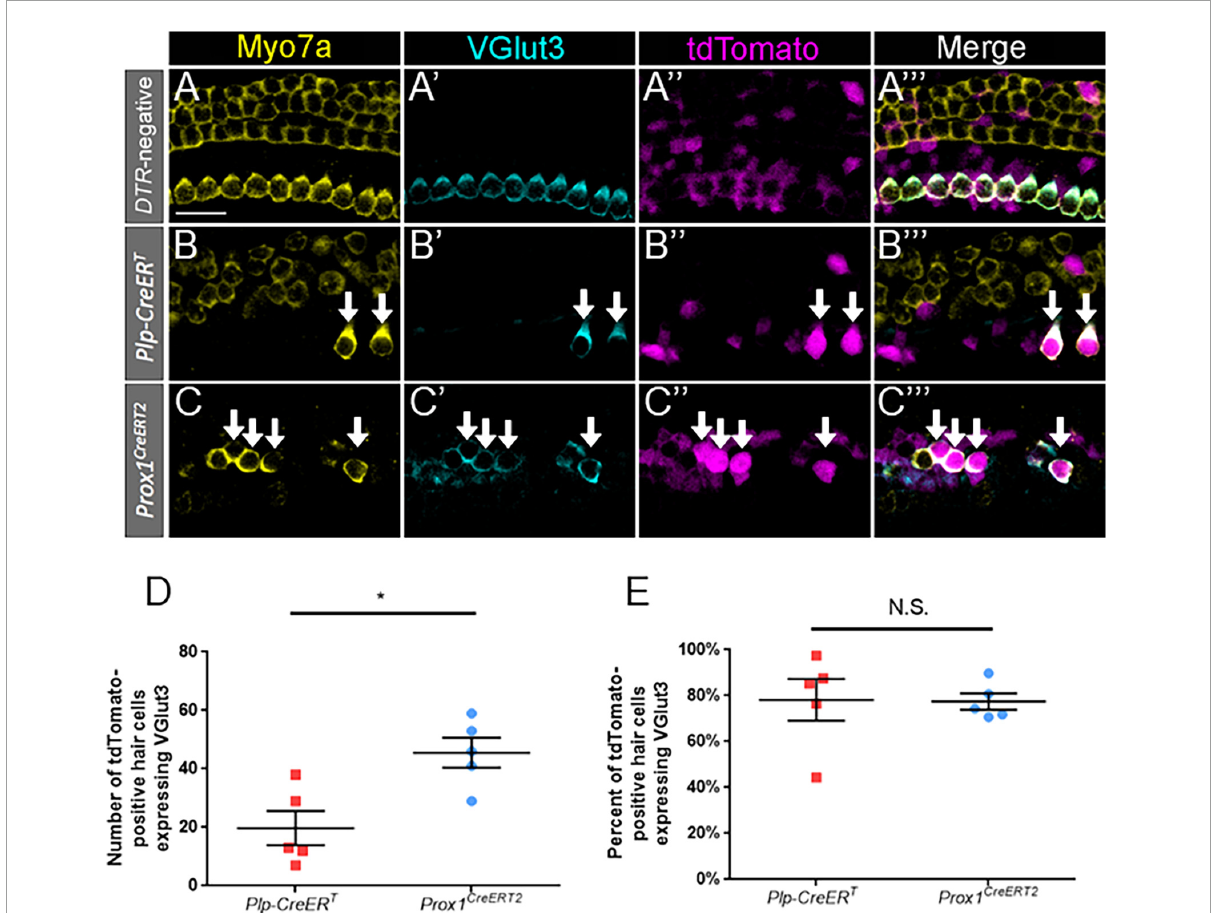
FIGURE5 VGlut3 is expressed in a similar proportion of regenerated hair cells across supporting cell subtypes. (A–C”’) Representative confocal slice images from the apical turn of Pou4f3 DTR -negative (A–A”’) , middle turn of Plp-CreER T :Rosa26 tdTomato :Pou4f3 DTR (B–B”’) , and apical turn of Prox1 CreERT 2 :Rosa26 tdTomato :Pou4f3 DTR (C–C”’) mice at P7–P8 that were injected with tamoxifen at P0 to induce tdTomato expression in the two supporting cell subpopulations and with DT at P1 to induce hair cell damage. Samples were immunostained with anti-Myo7a antibodies (yellow) to label hair cells and anti-VGlut3 antibodies (blue) to label mature inner hair cells. tdTomato was detected using endogenous fluorescence (magenta). Arrows indicate Myo7a-positive/VGlut3-positive/tdTomato-positive cells that are regenerated, fate-mapped mature inner hair cells. Scale bars: 25 µ m. (D) Significantly more regenerated hair cells derived from supporting cells in the lateral compartment and fate-mapped by Prox1 CreERT 2 expressed VGlut3. (E) When normalized to the total number of tdTomato-positive/Myo7a-positive cells, there was no significant difference in the percentage of VGlut3-positive regenerated hair cells between the supporting cell populations targeted by the two CreER lines. * p < 0.05, determined using an unpaired Student’s t -test. Data are presented as mean ± SEM; n = 5. N.S., not